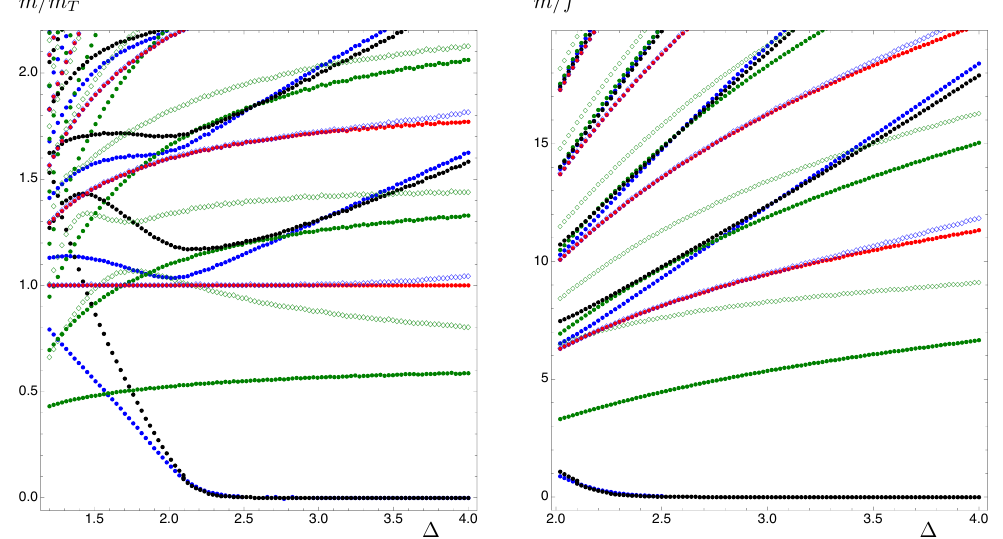
Figure 10 . Model I. Spectrum as a function of ∆ for x F = 2 , g 5 = 5 , ρ 1 = − 7 , ρ 2 = 10 . The left panel is normalized to the mass m of the lightest tensor, while the right panel is normalized T √ to the decay constant ˜ f ≡ f/ N C . The colour coding for the spectrum is: singlet scalar (blue), non-singlet scalar (blue diamonds), tensor (red), pseudoscalar (black), vector (green), axial-vector (green